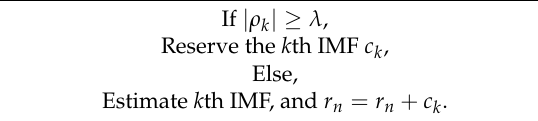
Table 1. The extraction criterion of true intrinsic mode functions (IMFs) based on the correlation